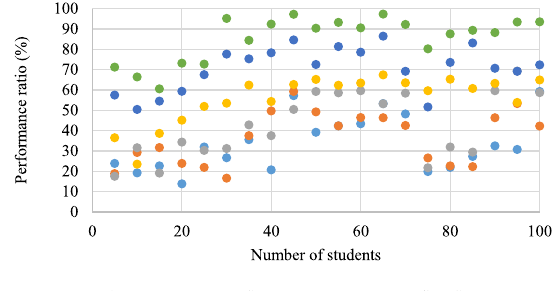
Fig. 8 Performance ratio of teaching quality